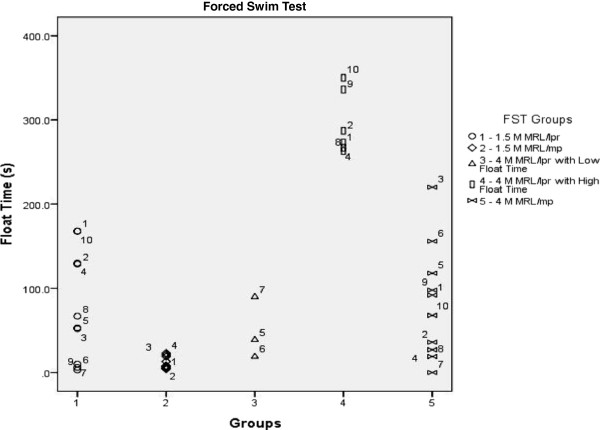
Forced Swim Test Study 2 – Group Separation within MRL/lpr by Neurobehavioral Manifestations. The forced swim test data was re-plotted to separate the 4 M MRL/lpr into two groups (3 and 4) based on their float times. The groups were as follows: 1 – 1.5 M MRL/lpr, 2 – 1.5 M MRL/mp, 3 – 4 M MRL/lpr low floaters, 4 – 4 M MRL/lpr high floaters and 5 – 4 M MRL/mp. Group 3 included mice 5, 6 and 7 and group 4 included mice 1, 2, 4, 8, 9 and 10. ANOVA revealed that there was a significant difference between the groups (F = 30.253, p < 0.001) and post-hoc analysis at p < 0.001 showed that the 4 M MRL/lpr low floaters were only significantly different from the 4 M MRL/lpr high floaters. The 4 M MRL/lpr high floaters were significantly different from all groups.